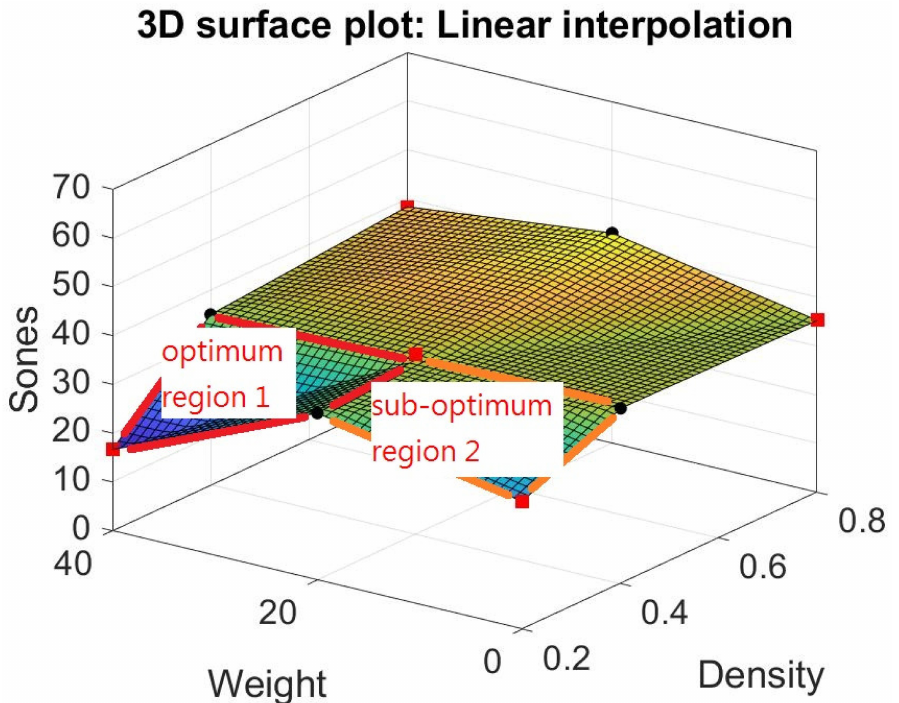
Figure 15. Two promising regions in linear interpolation.